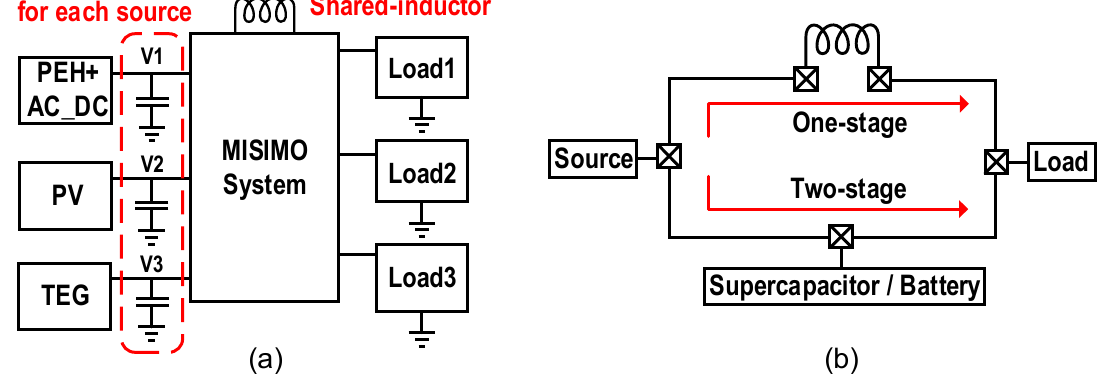
Figure 19. ( a ) System architecture of the MISIMO, ( b ) one/two-stage transfer schematic diagram. The maximum power point tracking for the MISIMO can be divided into two